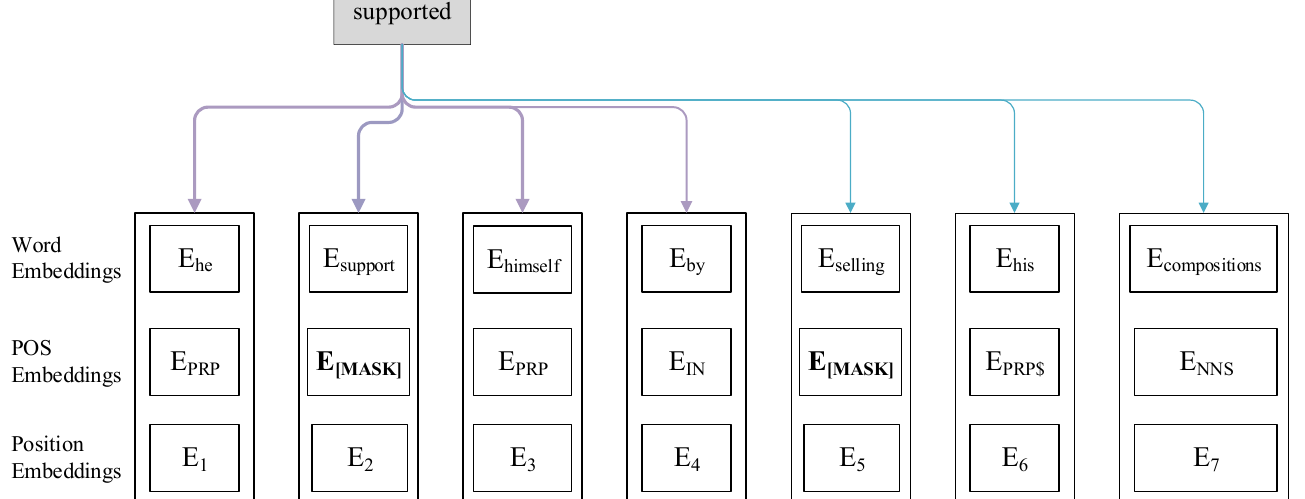
Figure 4. The self-attention mechanism in the model. The self-attention focuses not only on the word embedding and the position embedding of the token supported itself, but also on the information of the surrounding tokens, when the model predicts the POS tag of the token supported .